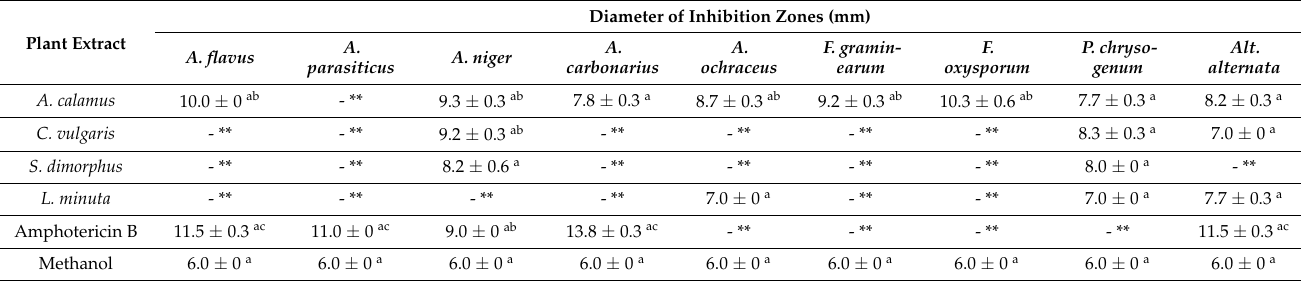
Table 1. Antifungal activity of methanolic extracts (64 mg/mL) of A. calamus, C. vulgaris, S. dimorphus and L. minuta (mean ± SD)